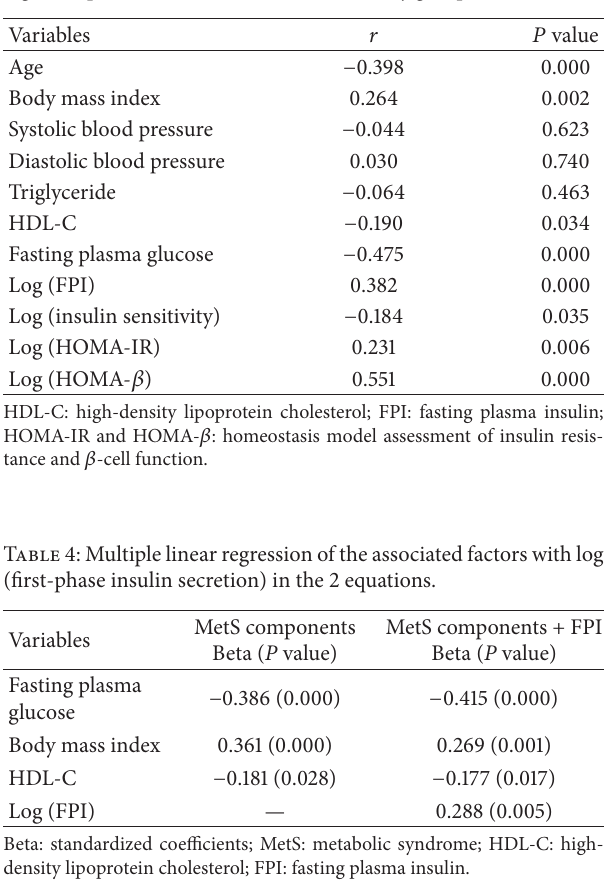
Table 3: Pearson correlation between the clinical parameters and log (first-phase insulin secretion) in the study group.